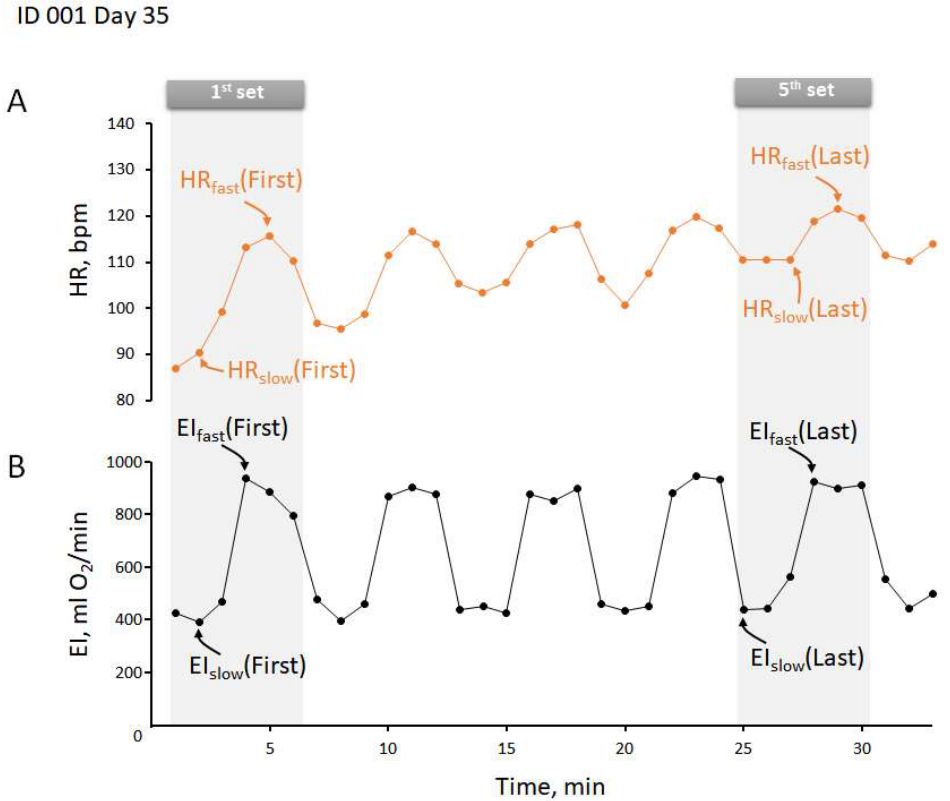
Figure 2. A typical example of heart rate (HR) ( A ) and exercise intensity (EI) ( B ) responses during IWT. HR slow and HR fast are HR for slow and fast walking, respectively. Similarly, EI slow and EI fast are EI for slow and fast walking. The suffixes of “First” and “Last” indicate HR and EI for the first set and the last set of IWT, respectively.